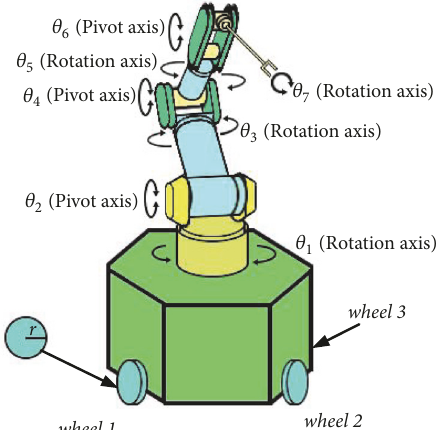
Figure 1: 3D integration model of mobile manipulator with three Swedish wheels.